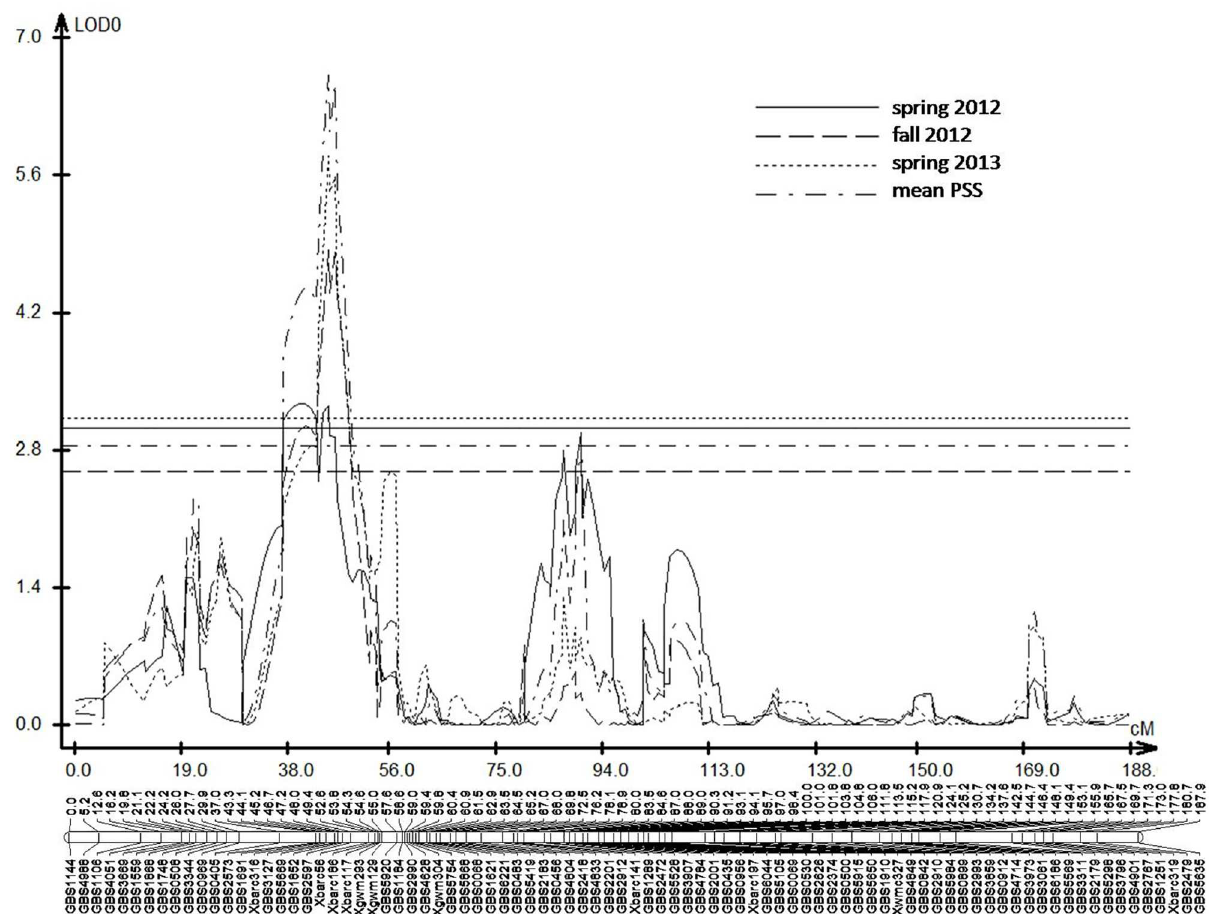
Fig 2. Maps of QTLs on 5A for FHB type II resistance constructed from the RIL population derived from the cross ‘HYZ’ x ‘Wheaton’ based on three greenhouse experiments.